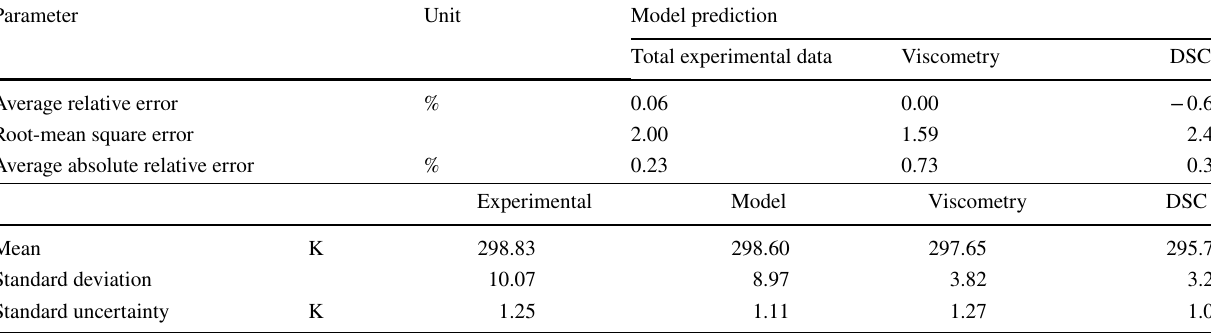
Table 10 Statistics of total used WDT data and those measured by viscometry and DSC Parameter